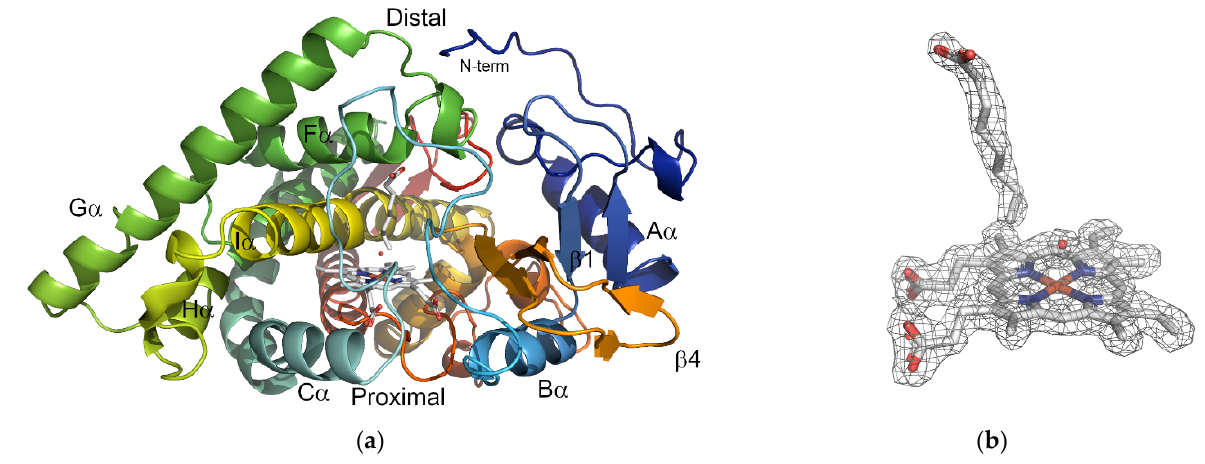
Figure 6. ( a ) Overall fold of CYP153A71 colored blue (N ‐ terminus) to red (C ‐ terminus). Numbering of helices and strands according to CYP101A1 (P450cam); ( b ) octanoic acid bound on the proximal side of the heme in chain A. Fe ‐ coordinated water is shown as a red sphere. Electron density is displayed as mesh contoured at σ = 1 from a 2Fo ‐ Fc map.